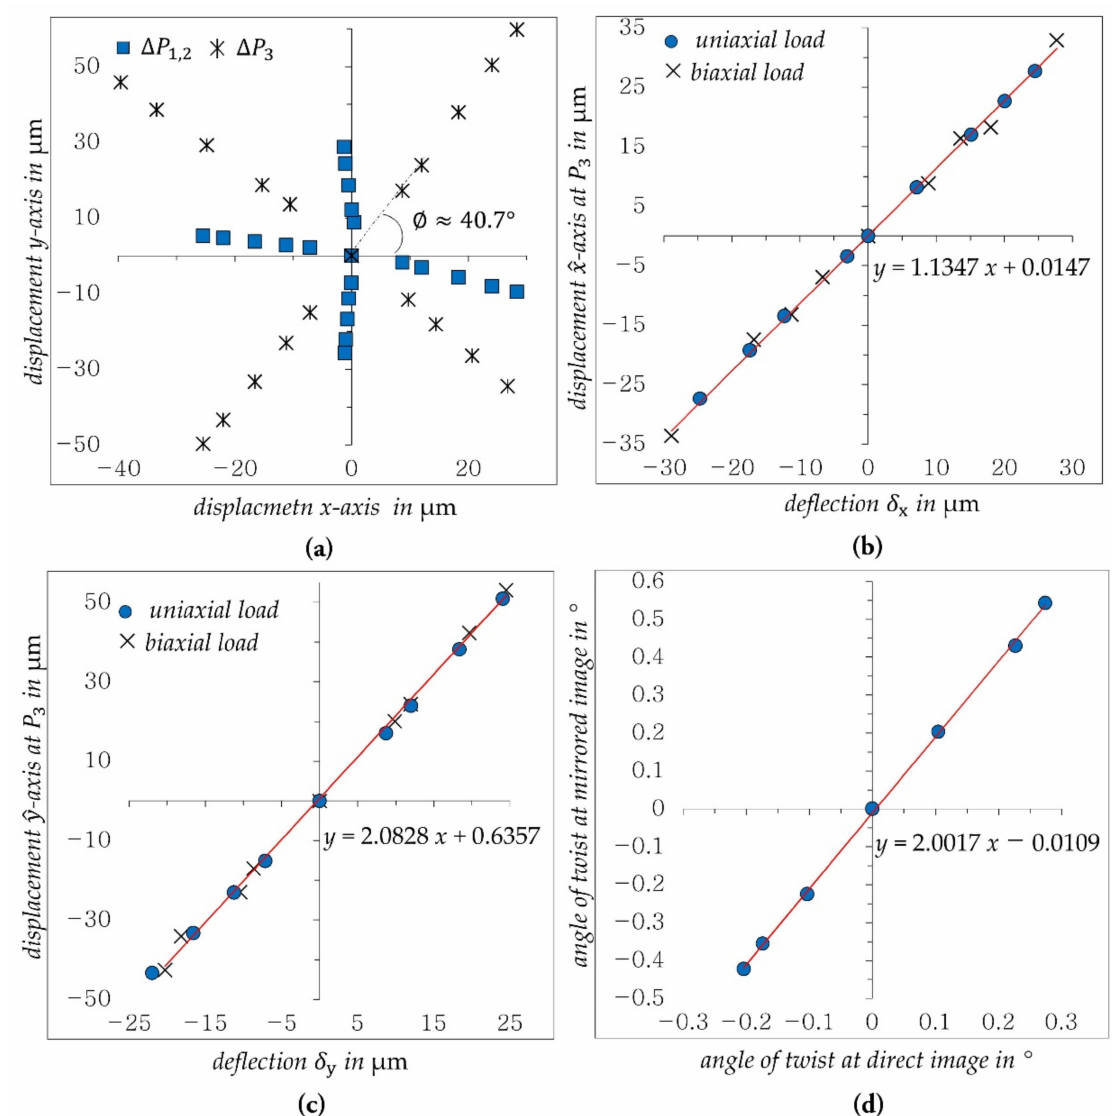
Figure 8. Characterization of sensor behavior, ( a ) determined angle of boundary line ∅ , ( b ) determined crosstalk between δ x and P 3 _ ˆ x for uniaxial ( F x ) and biaxial ( F xy ) loading, ( c ) determined crosstalk between δ y and P 3 _ ˆ y for uniaxial ( F y ) and biaxial ( F xy ) loading, ( d ) crosstalk of the twist angle ϕ on mirrored image